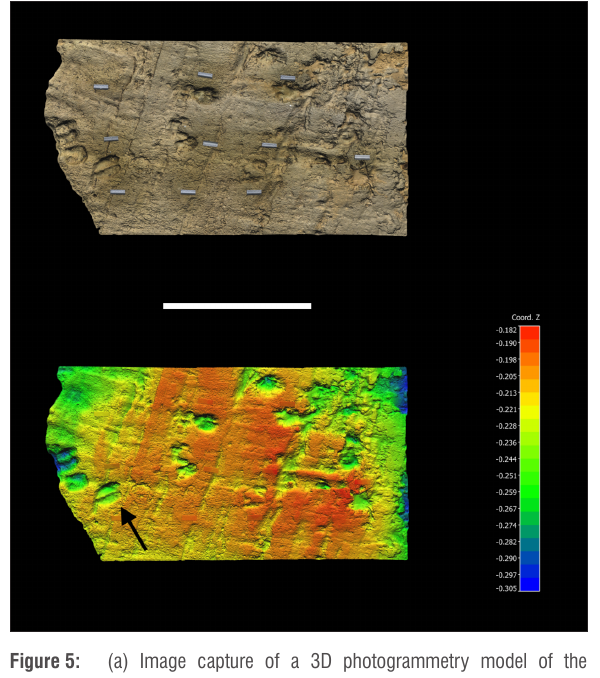
Figure 5: (a) Image capture of a 3D photogrammetry model of the giraffe track site. (b) Photogrammetry colour mesh of the giraffe track site. The arrow indicates the track featured in Figure 6. The 3D model was generated with Agisoft Photoscan Professional (v. 1.0.4) using 592 images from a Canon PowerShot D30 (focal length 5 mm; resolution 4000 x 3000; pixel size 1.5494 µm x 1.5494 µm). Photos were taken an average 0.27 m from the surface. The surface model error is 0.142808 pix. The final images were rendered using CloudCompare (v.2.6.3.beta). White horizontal scale bar (centre) is 1 m. Vertical scale is in metres.